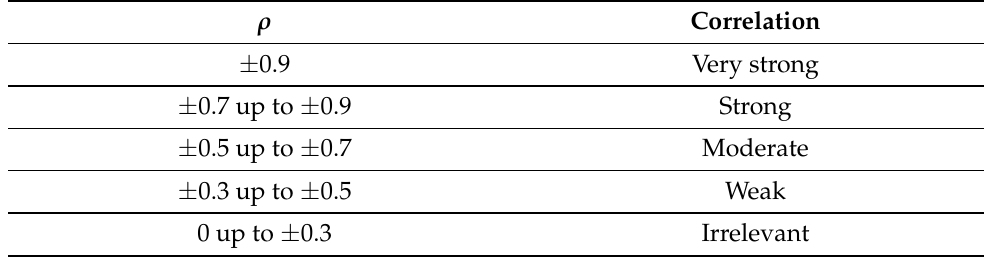
Table 1. Classification ranges for the very values of ρ